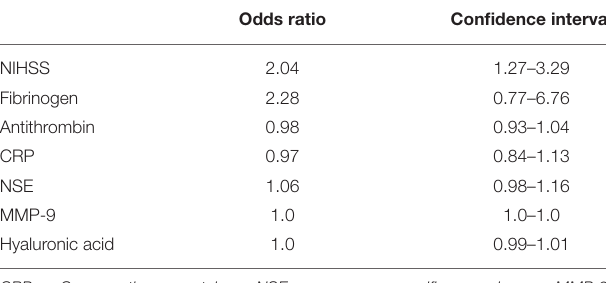
TABLE 4 | Odds ratios with confidence intervals for the NIHSS score and each laboratory parameter that was included into the model to differentiate between patients with minor ischemic stroke and transient ischemic attack within 24h after symptom